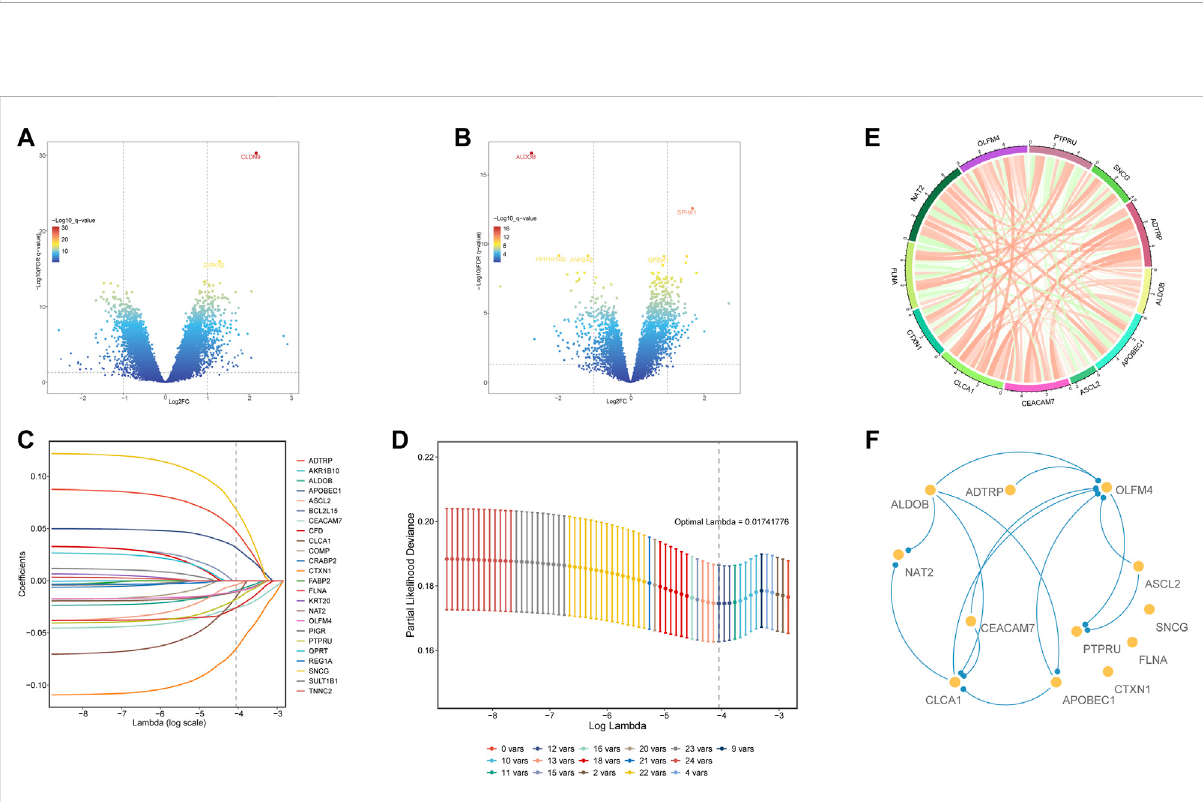
Frontiers in Cell and Developmental